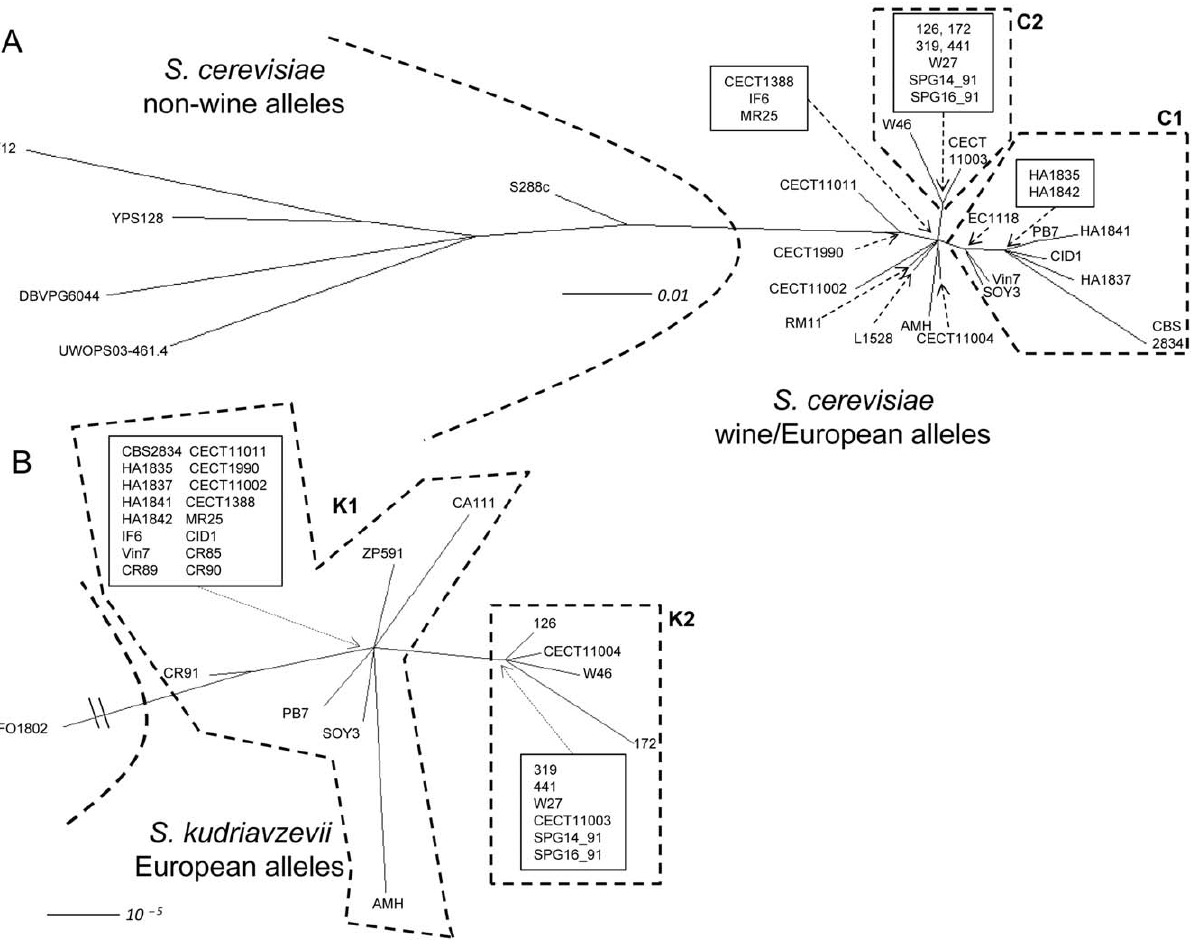
*The most frequent haplotype. a Only those alleles present in more than one strain were included.